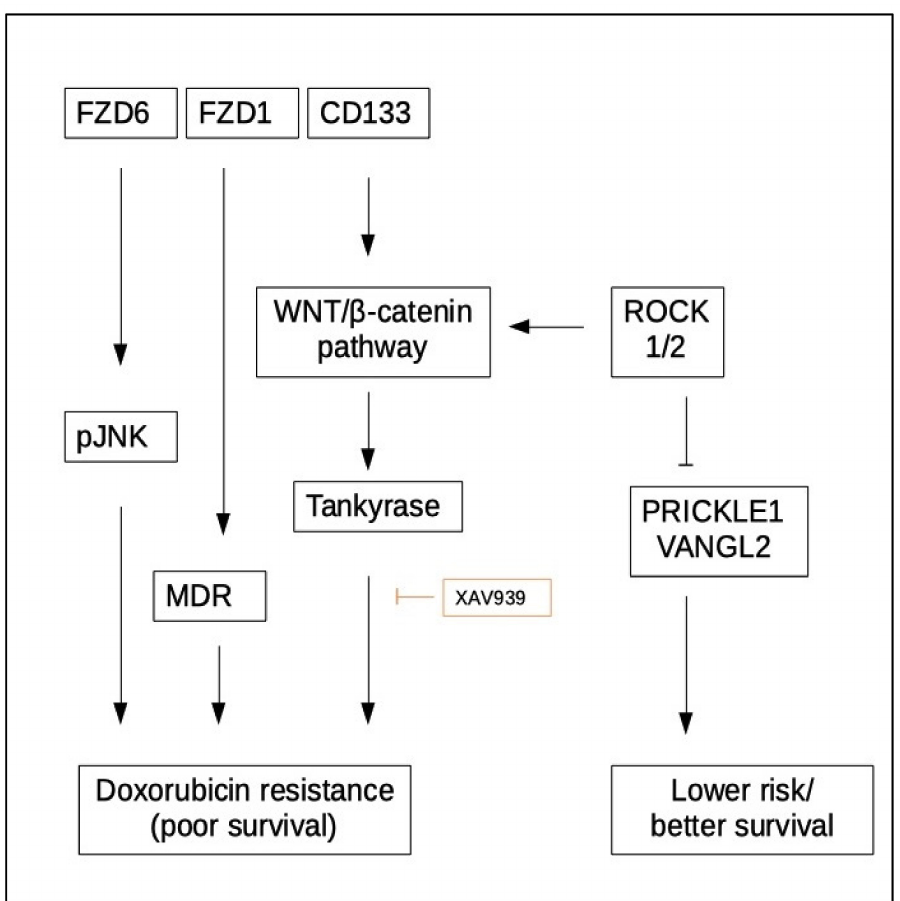
Figure 2. WNT pathway molecules and their involvement in chemoresistance in NB. For detailed, information please see